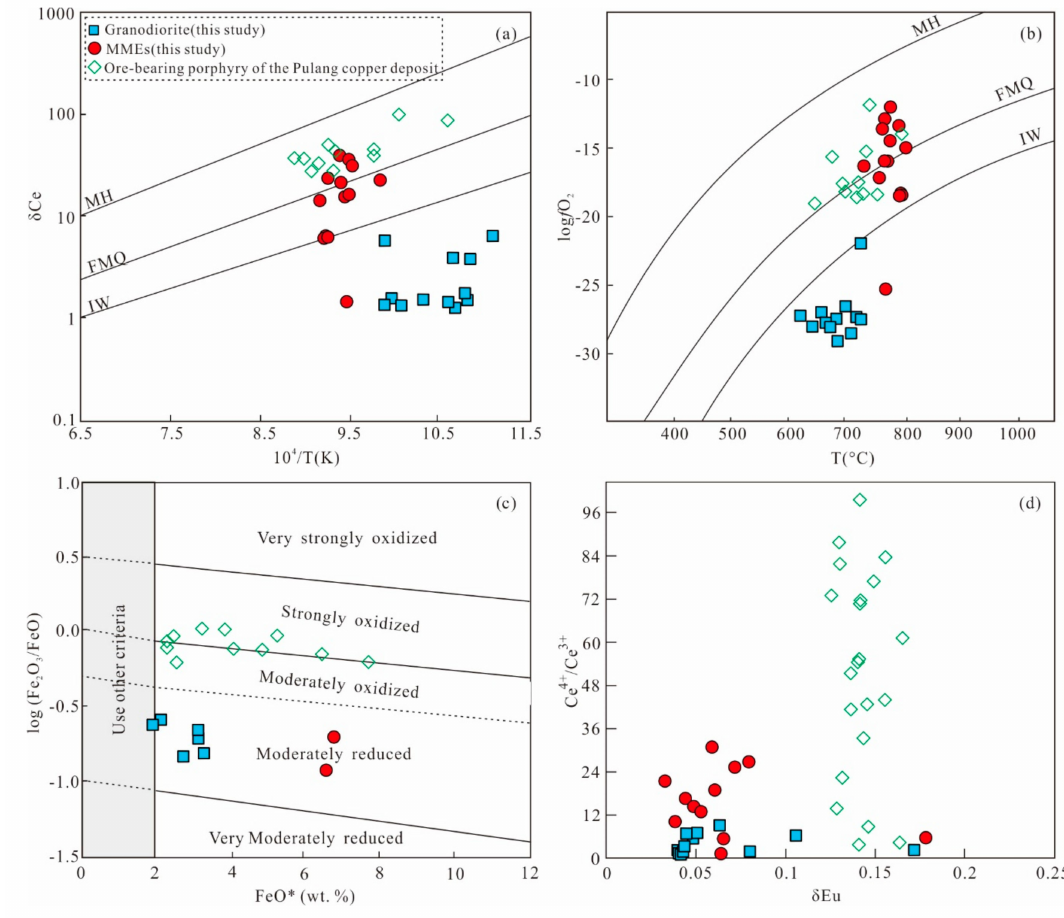
Figure 11. Magmatic oxidation states of the Daocheng batholith. ( a ) Ce anomalies vs. 10 4 / T (K) diagram (after [83]); ( b ) log f O 2 vs. T ( ◦ C) diagram (after [79]); ( c ) whole-rock log (Fe 2 O 3 / FeO)